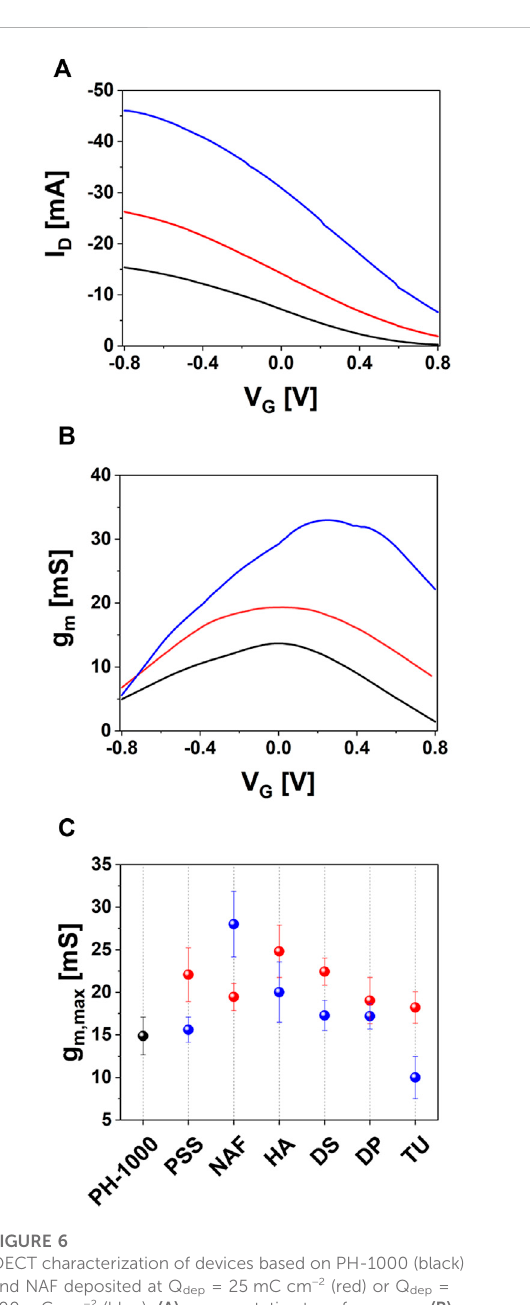
FIGURE 6 OECT characterization of devices based on PH-1000 (black) and NAF deposited at Q dep = 25 mC cm − 2 (red) or Q dep = 100 mC cm − 2 (blue): (A) representative transfer curves, (B) transconductance plotted with the drain voltage (V D ) fi xed at − 0.8 V and (C) max transconductance g m,max extracted for OECTs based onPH-1000 (black dots)andPEDOT/NAF deposited at Q dep = 25 mC cm − 2 (red dots) or Q dep = 100 mC cm − 2 (blue dots) (mean ± SD from a set of three different